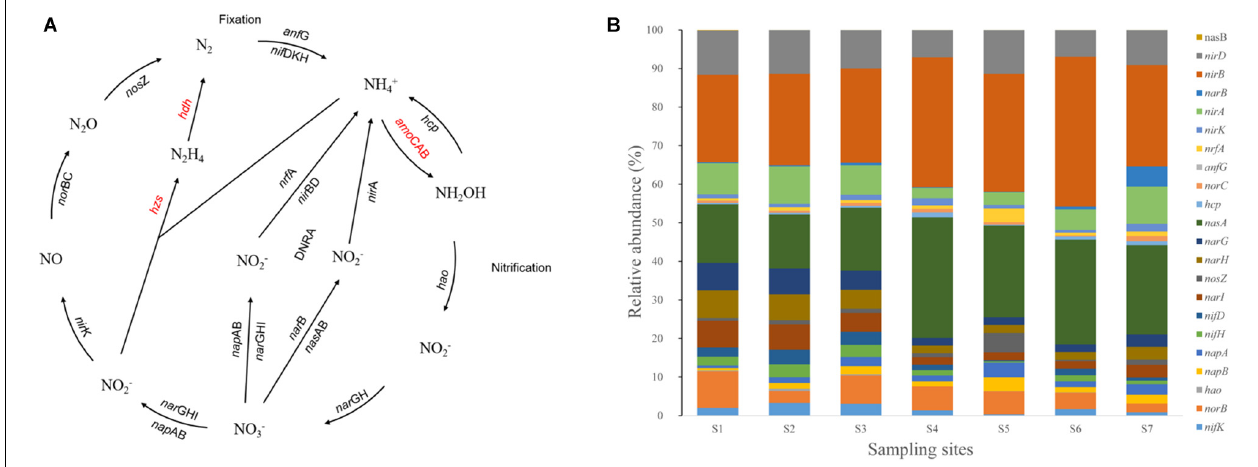
FIGURE 5 | Predicted nitrogen cycling pathway modified from KEGG (A) . Red-colored genes were not predicted by the PICRUSt or were undetected in the indicated samples. Gene relative abundance in nutrient-cycling processes (B)